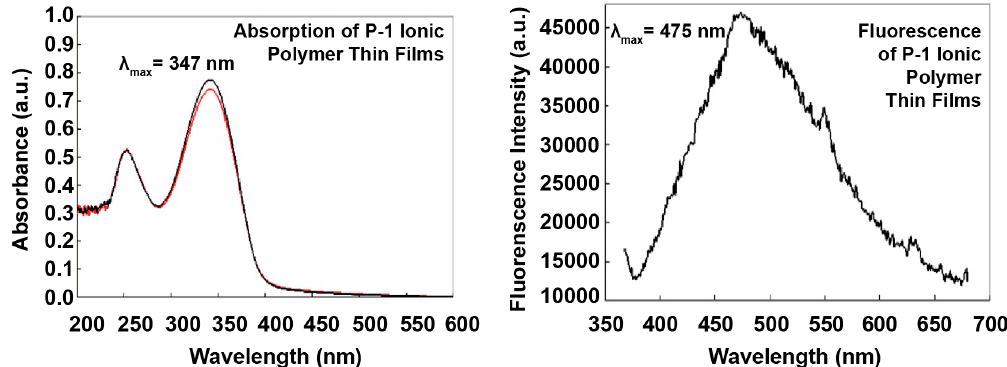
Figure 8. Absorption (left) and fluorescence (right) spectra of P-1 thin films on glass substrates.